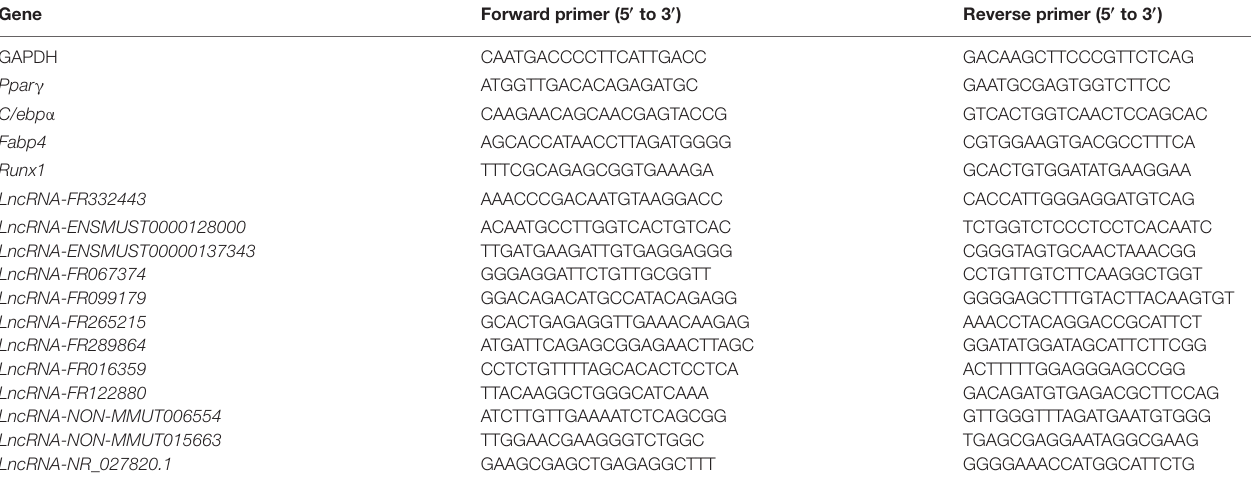
TABLE 1 | Real-time RT-PCR primer sequences. Gene Forward primer (5 (cid:48) to 3 (cid:48) ) Reverse primer (5 (cid:48) to 3 (cid:48)